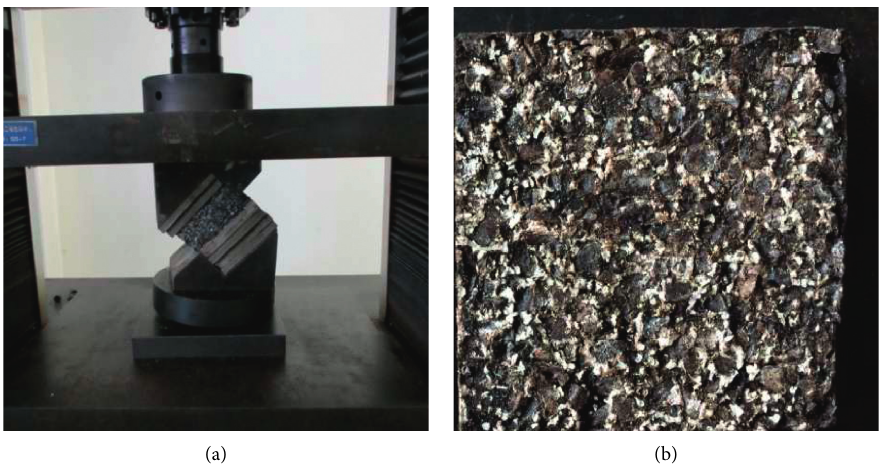
Figure 11: Inclined shear test. (a) Test setup. (b) Failed interface.